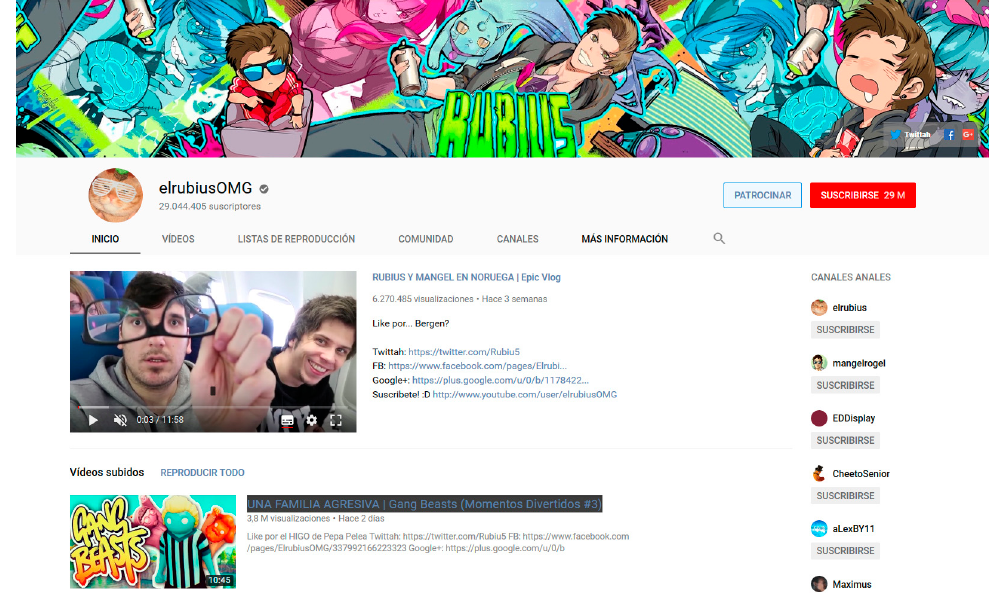
Figure 4. Frontpage of the YouTube channel, elRubius.